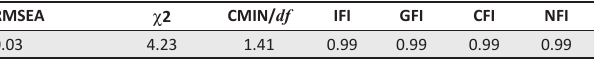
RMSEA, root mean square error of approximation; CMIN, chi-square value; df , degrees of